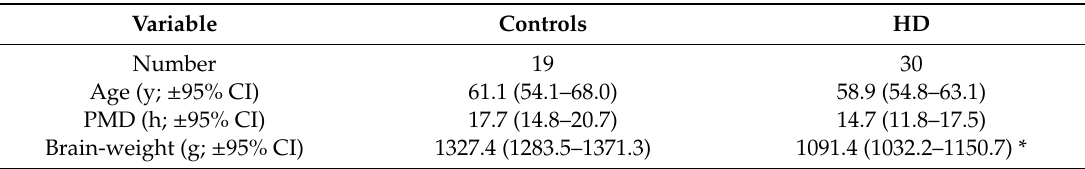
Table 1. Table showing study-group